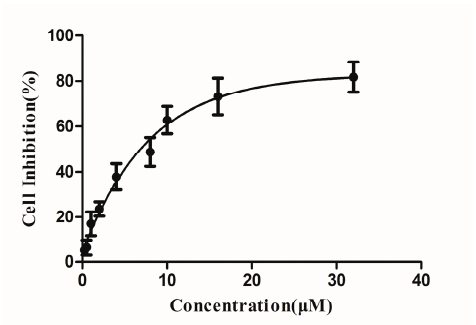
Figure 3. Cytotoxicities of di- n -butyl-di-(4-chlorobenzohydroxamato)tin (DBDCT) to Rat Liver (BRL) cells for 24 h. Results are shown as the inhibition rate, which was expressed as the mean ± SD of three experiments.